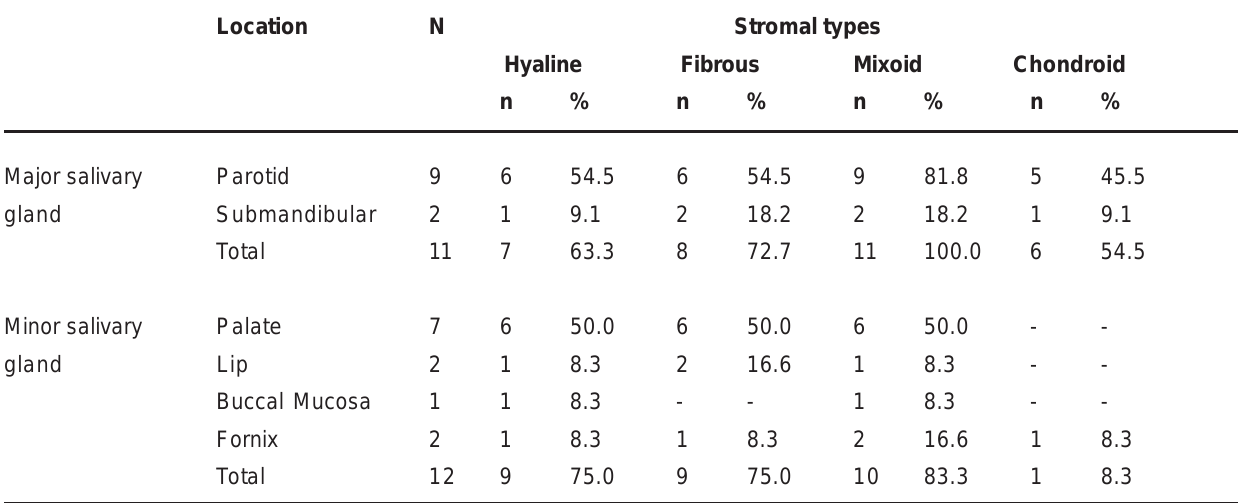
N= number of cases per location. n= number of cases per stromal type